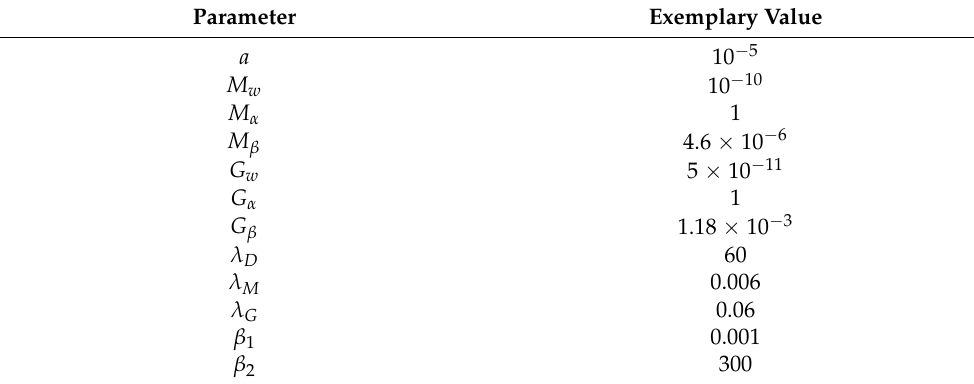
Table 6. The values of individual parameters used to calculate the number of signals and the number of damages associated with the bystander effect [3], as well as the probability distribution of its occurrence